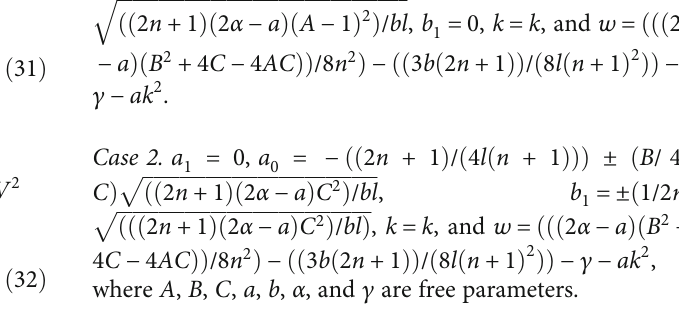
, x Þ at x = 1 : 0 in Equation (27) for di ff erential values of the fractional parameter Figure 4: The positive real part of u 3 1 ð t